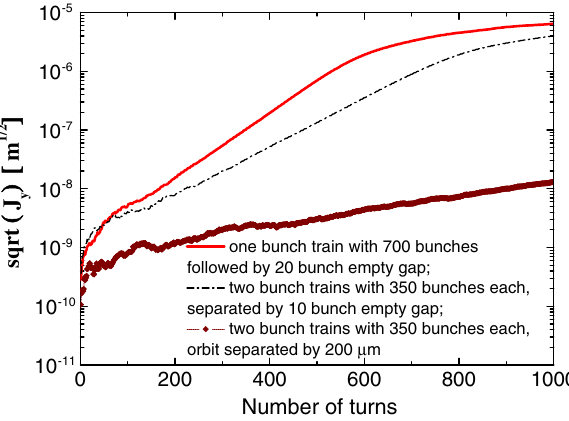
FIG. 6. Growth of the maximum oscillation amplitude of the electron bunch centroid for the same parameters used in the ion trapping simulation in Fig. 5.